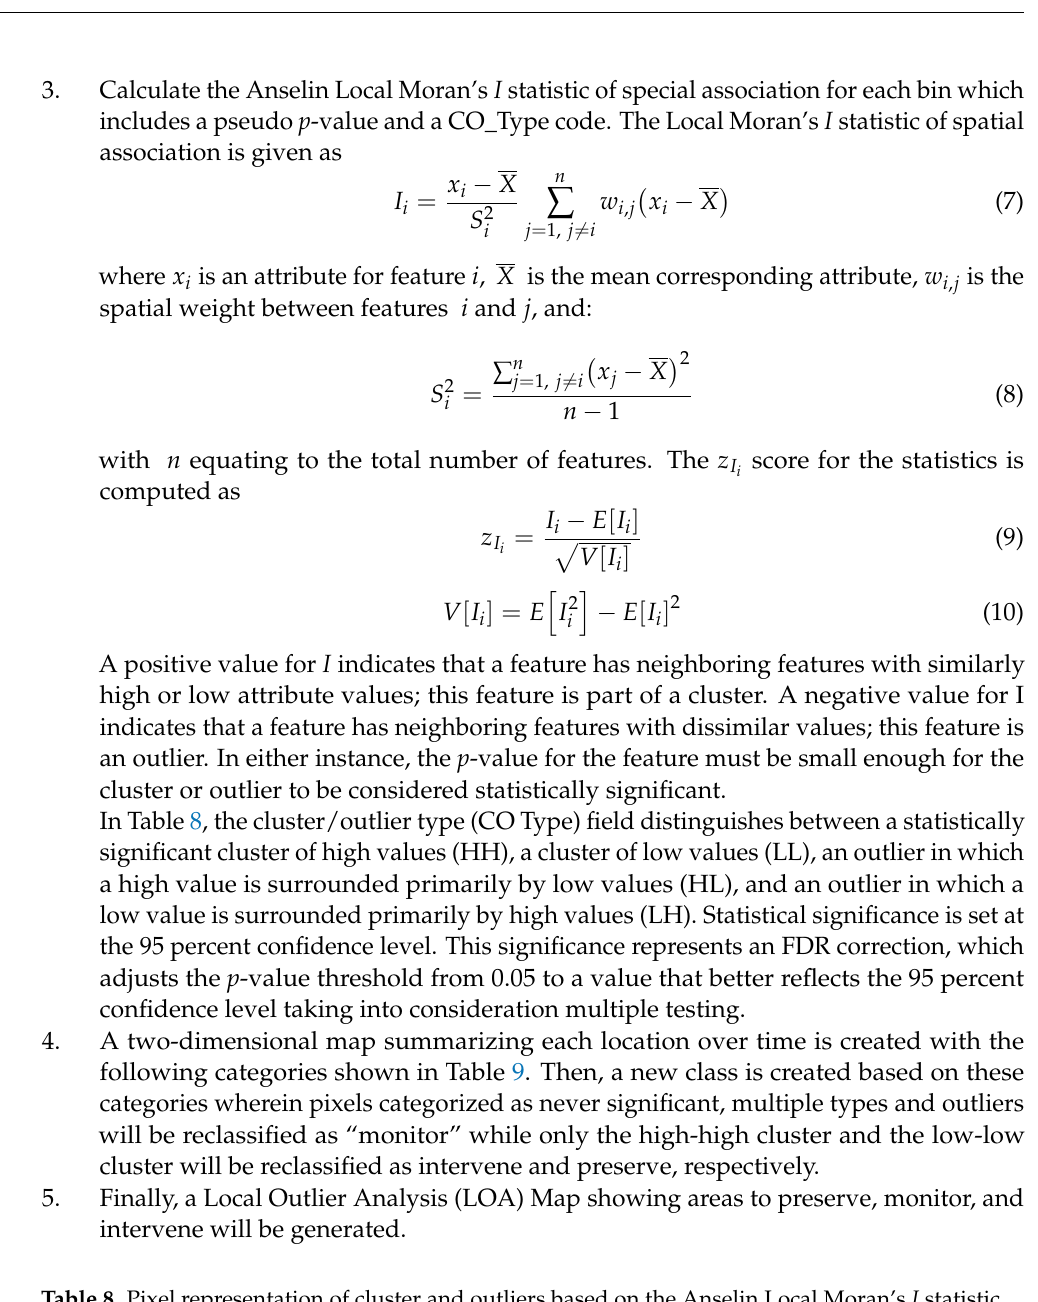
Table 8. Pixel representation of cluster and outliers based on the Anselin Local Moran’s I statistic. Cluster/Outlier